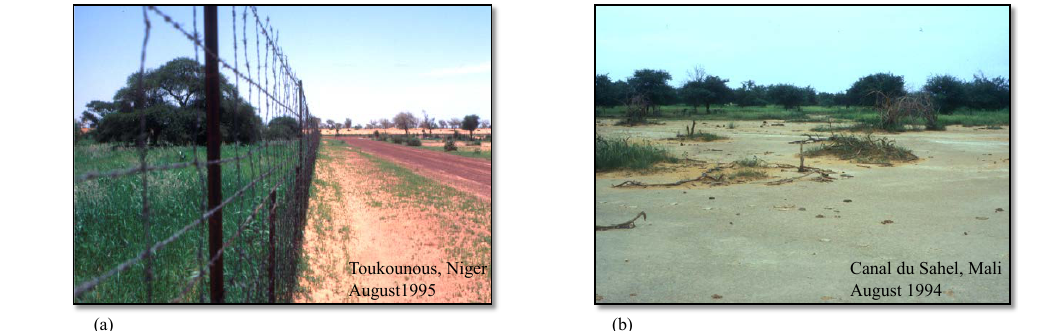
Figure 3. (a) Toukounous, Niger (August 1995). (b) Canal du Sahel, Mali (August 1994).